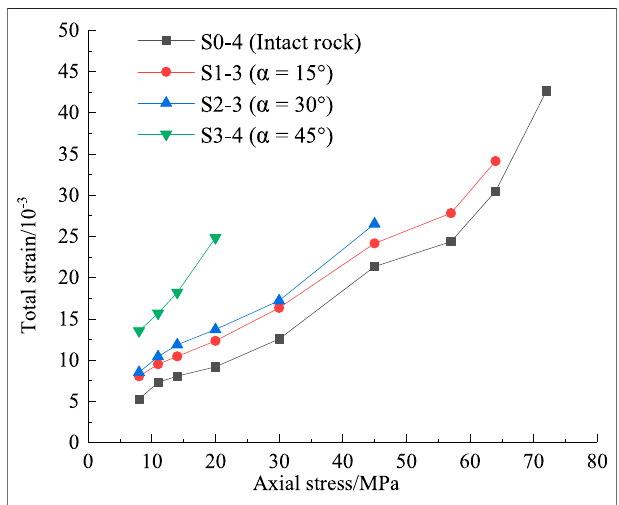
FIGURE 13 | Total strain curves of specimens from the fi rst to the last stress levels.